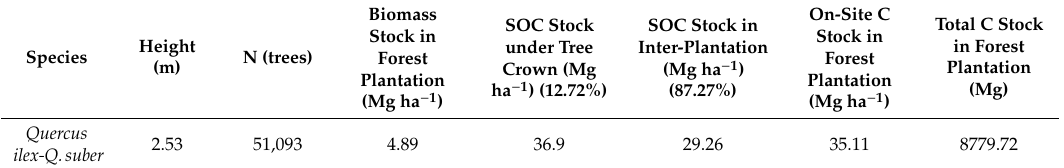
Table 5. Distribution of biomass C stock (Mg ha − 1 ) and SOC stock (Mg ha − 1 ) in the Quercus ilex-Q. suber plantation on agricultural land in Southwestern Spain. Overall area: 250 ha (% of total